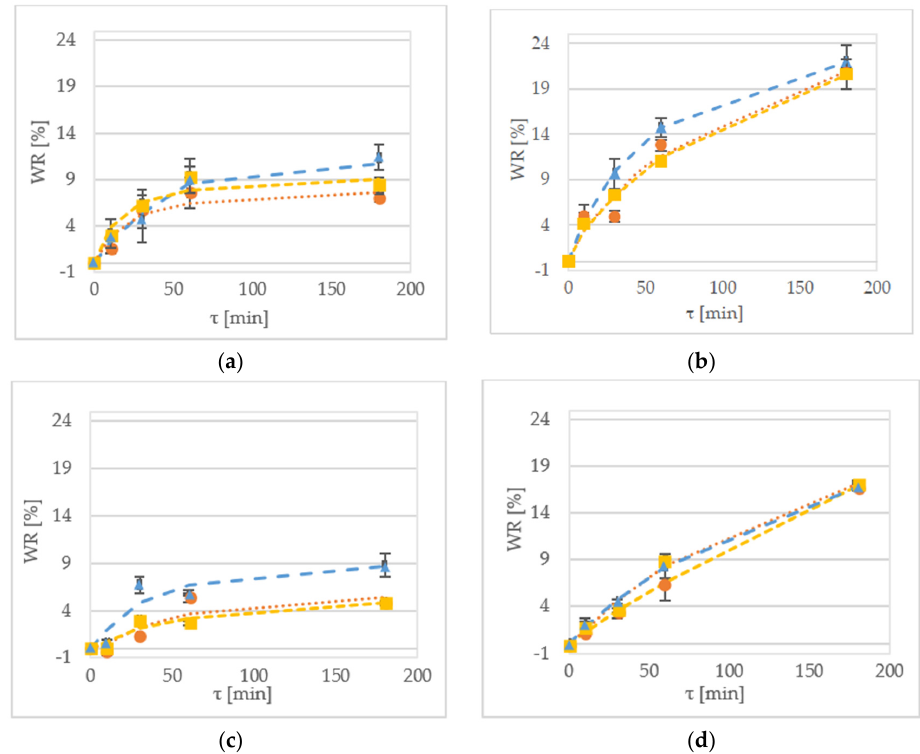
Figure 1. WR kinetics of the ‘Geneva’ cultivar dehydrated at ( a ) 30 °C; and ( b ) 50 °C in xylitol ( ▲ —triangle), maltitol ( ■ —square) and sucrose ( ● —circle). WR kinetics of the ‘Weiki’ cultivar dehydrated at ( c ) 30 °C; and ( d ) 50 °C in xylitol ( ▲ —triangle), maltitol ( ■ —square) and sucrose ( ● —circle). Dotted lines represent values obtained from the mathematical modelling.